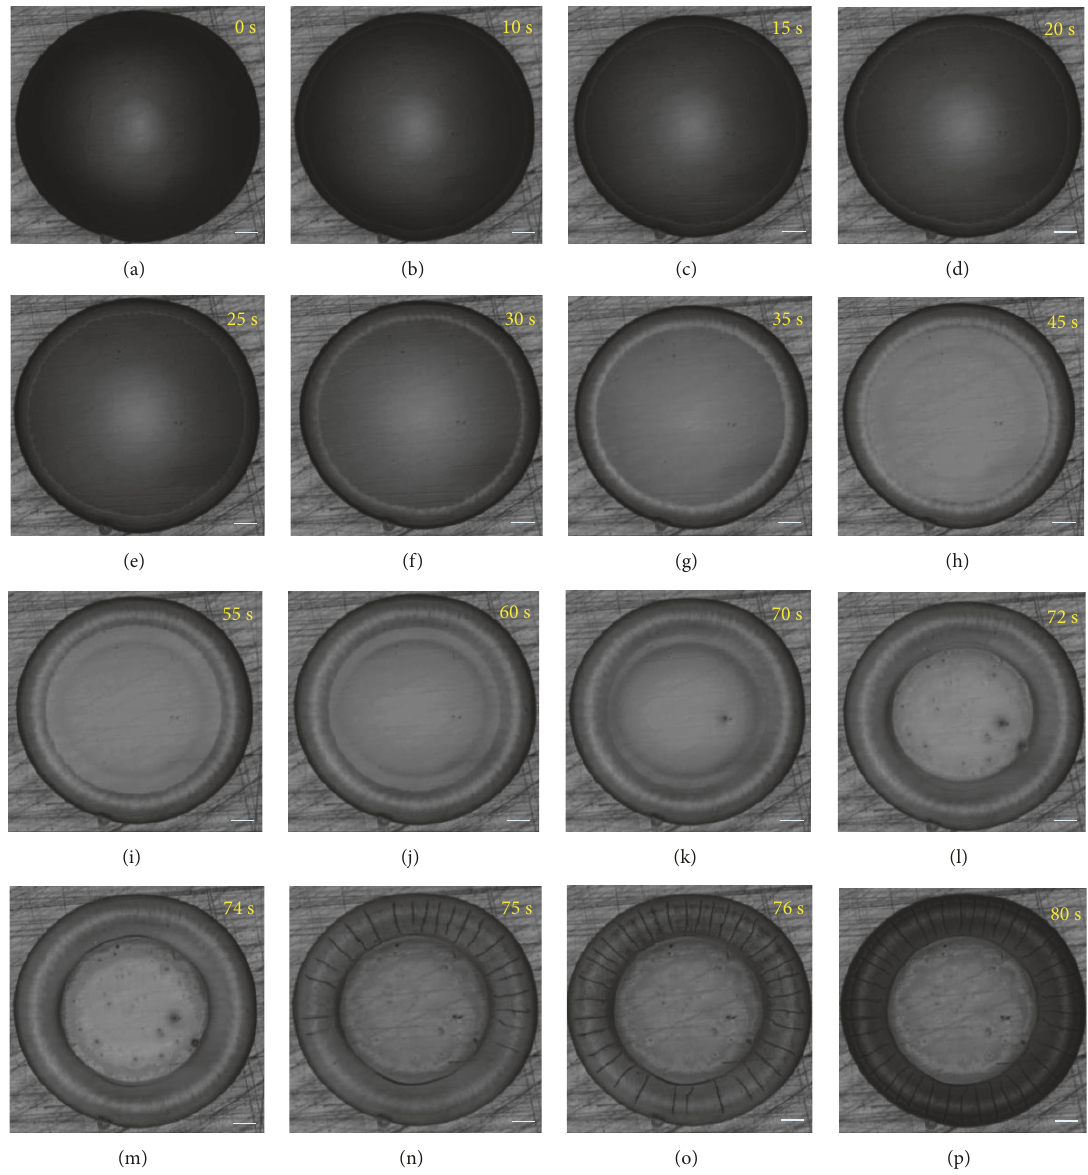
Figure 5: Evaporation dynamics of PTFE droplet on rough substrate, (a)–(p) correspond to different evaporation time. The mesh of sand paper used is 200 (scale bars represent 100 𝜇